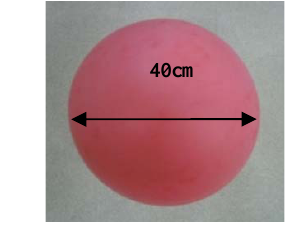
Figure 4. Spherical Rubber Balloon